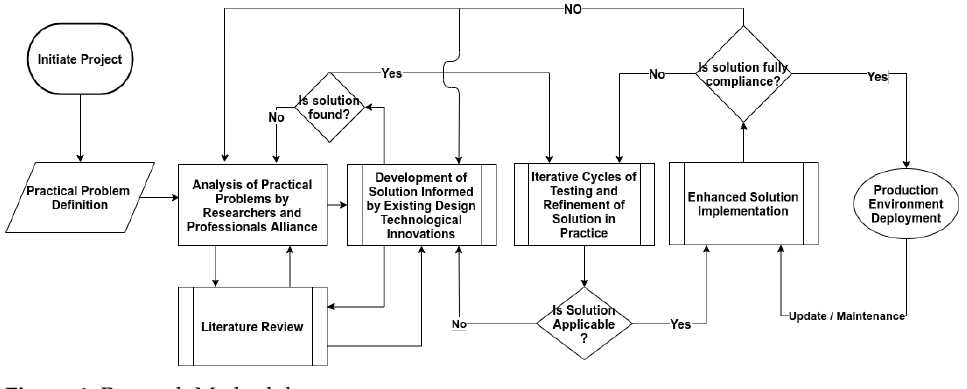
Figure 4. Research